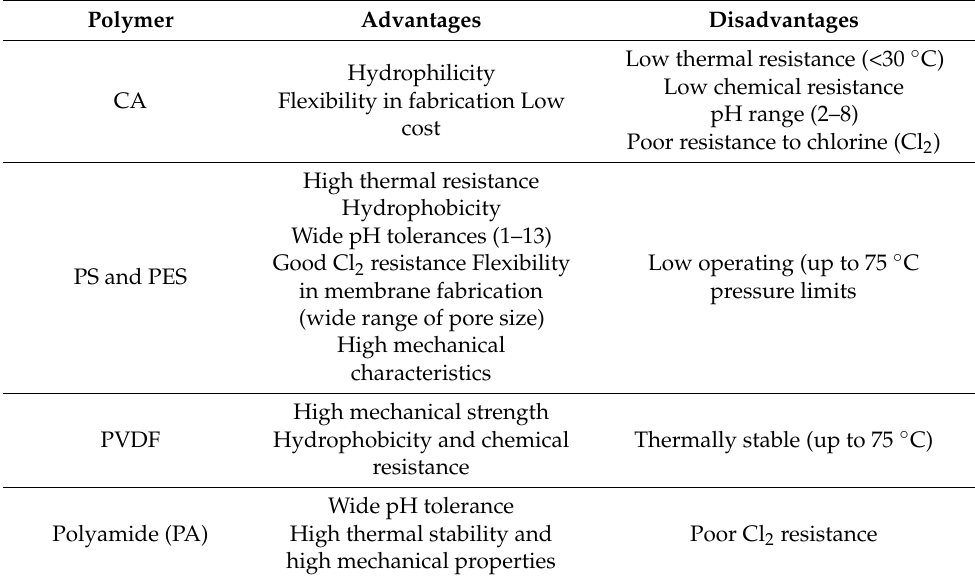
Table 15. Main polymers used for film formation and the advantages and disadvantages [270]. Reproduced with permission from Smitha, B.; Sridhar, S.; Khan, A.A, Journal of Membrane Science; published by Elsevier B.V.,